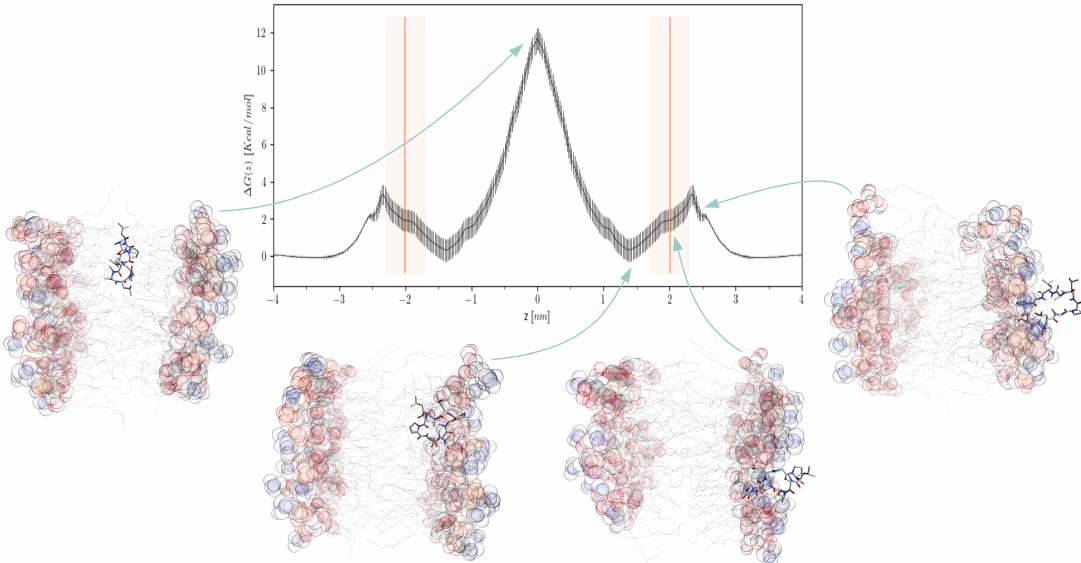
Figure 1. Symmetrized CDP5 free energy profile computed from umbrella sampling trajectories. Error bars were estimated using the gmx wham bootstrap algorithm [24]. The orange vertical line and shaded area indicate the mean and one σ of the lipid headgroup positions, respectively. Free energy difference ∆ G ( z ) = G ( z ) − G ( z max ) was calculated with z max = 3.8 nm in the water phase. Four representative structures of the peptide-membrane system are shown for the peptide positions z = 0.0, 1.4, 2.0, and 2.7 nm. Peptides, lipid headgroups, and lipid tails are displayed using sticks, semi-transparent spheres, and lines,